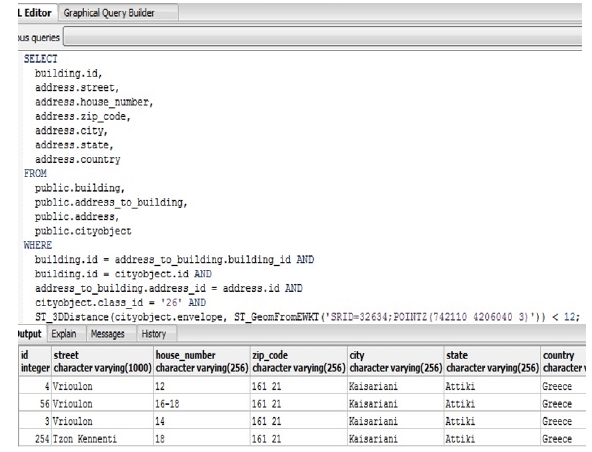
Figure 12. Example #2 of Spatial Query on PostgreSQL Database